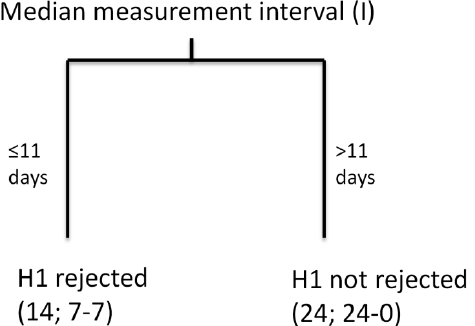
Figure 4. Classification and regression tree (CART) showing for which groups of experiments our hypothesis (H1: the moisture re- sponse of soil CO2 efflux (SCE) as observed in the controls can be used to predict SCE in the treatment) could and could not be rejected. This CART analysis included as a weight factor the recip- rocal of the number of experiments per site to take into account their interdependence. The key predictor variable (the median measure- ment interval) is depicted at the top, and predictor variable thresh- olds are at the side of each branch. Below the terminal nodes, the values between brackets display: total number of experiments; num- ber of experiments for which H1 was not rejected - number of ex- periments for which H1 was rejected. A list of all predictor variables included in the CART-analysis is given in the Methods section. This analysis used the 38 experiments for which results from the entire dataset and the common SWC subset agreed (i.e., robust results).